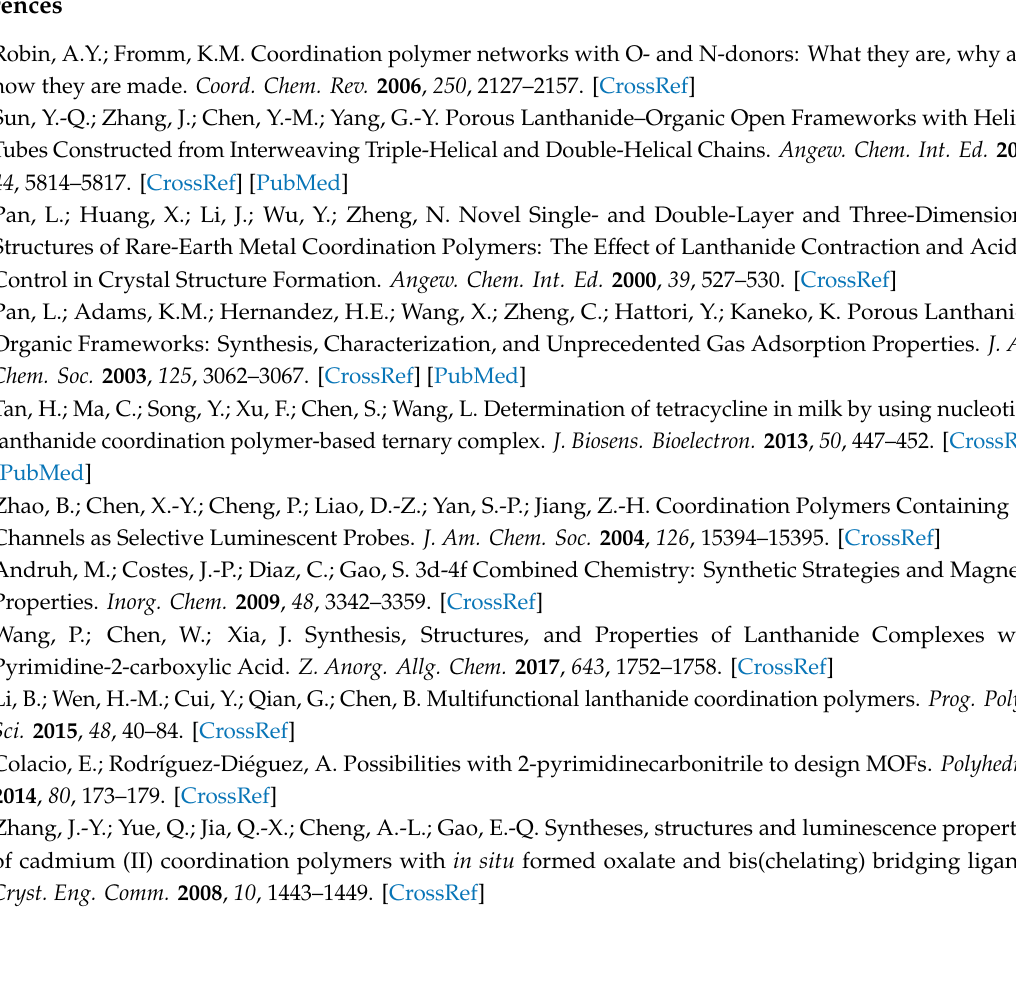
Crystallographic Data: Table S1: Selected bond lengths (Å) for complex 1 , Table S2: Selected bond lengths (Å) for complex 2 , Table S3: Selected bond angles ( ◦ ) for complex 1 , Table S4: Selected bond angles ( ◦ ) for complex 2 , Figure S1. Perspective views of the Dy 3 + ions in the crystal structure of 1 . Hydrogen atoms are omitted for clarity. IR spectra: Figure S2. IR spectrum of 2-pyrimidinecarbonitrile ligand, precursor of pymca ligand, Figure S3. IR spectrum of [Dy 4 (pymca) 4 (AcO) 8 ] n (compound 1 ), Figure S4. IR spectrum of [Nd 4 (pymca) 4 (AcO) 8 ] n (compound 2 ). Continuous Shape Measurements for compounds: Table S5. Continuous Shape Measurements for compounds 1 and 2 considering a coordination number of 9, Table S6. Continuous Shape Measurements for Dy2 in compound 1 , considering its eight-coordination. Magnetic Measurements: Figure S5. Temperature dependence of in-phase (red) and out-of-phase (blue) components of the ac susceptibility in a zero (top) and under 1 kOe applied dc field (down) for 1 . Photoluminescence measurements: Figure S6. Excitation spectrum for the ligand